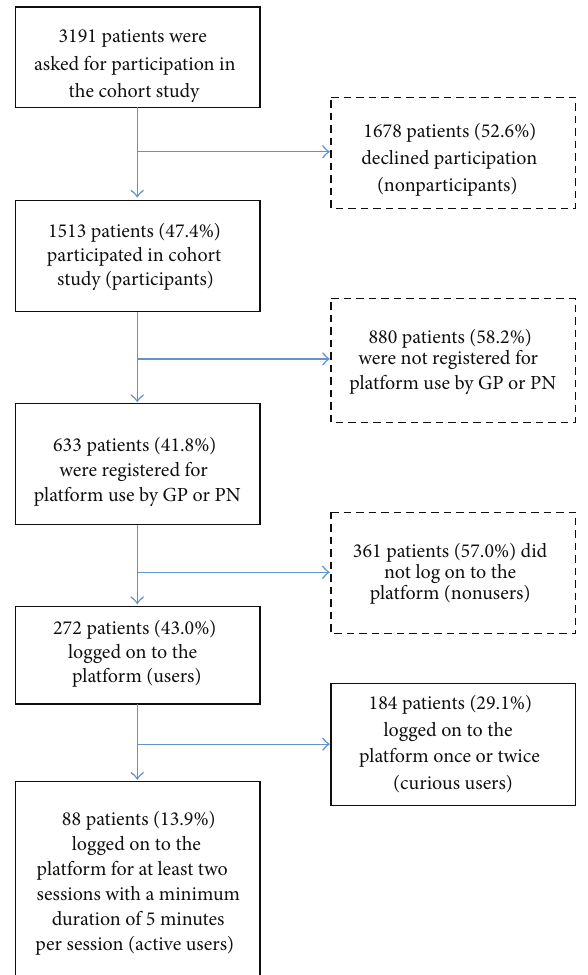
Figure 1: Flowchart of patients and